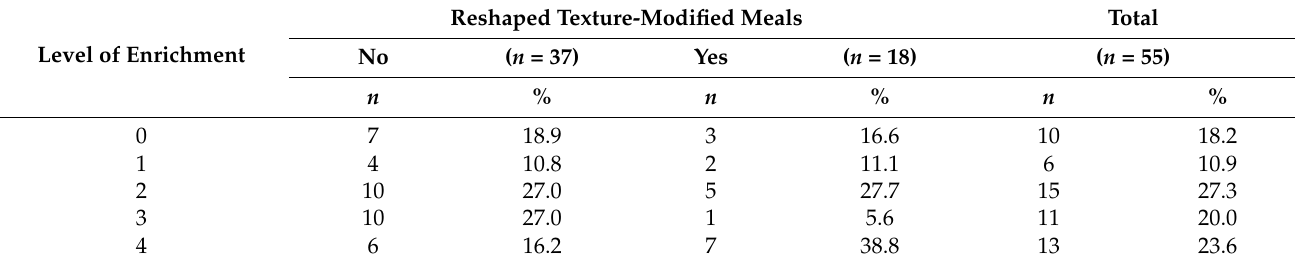
Table 3. Number of residents in enrichment levels stratified by reshaped texture-modified meals.